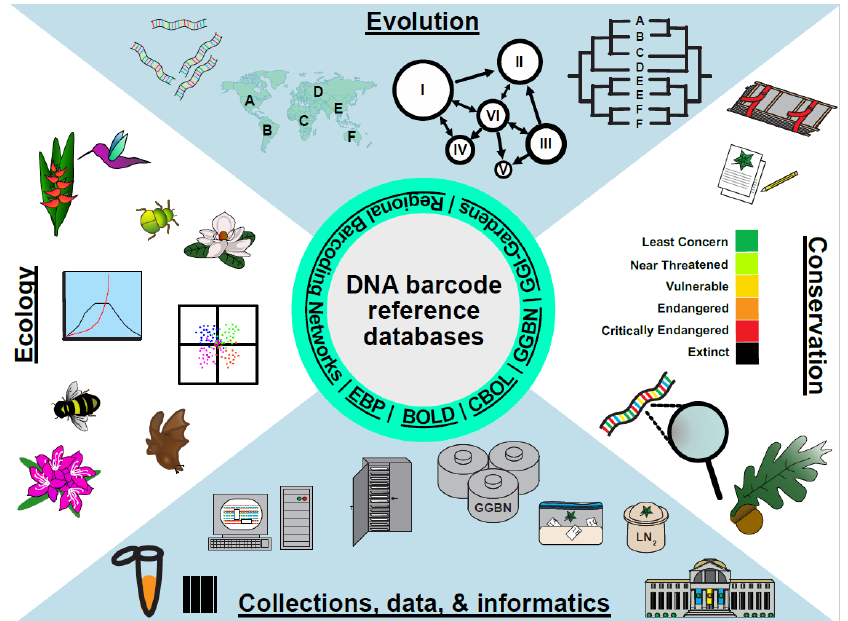
Figure 2. A graphical representation of DNA barcoding today. DNA barcode applications in ecology (left), evolution (top), and conservation (right) are supported by a foundation of collections, metadata, and informatics (bottom). These applications are facilitated by increasingly large DNA barcode reference databases (center circle) that are reciprocally built from and contribute to the major biological disciplines. National and international initiatives that support the growth of DNA barcode reference databases are core resources (green